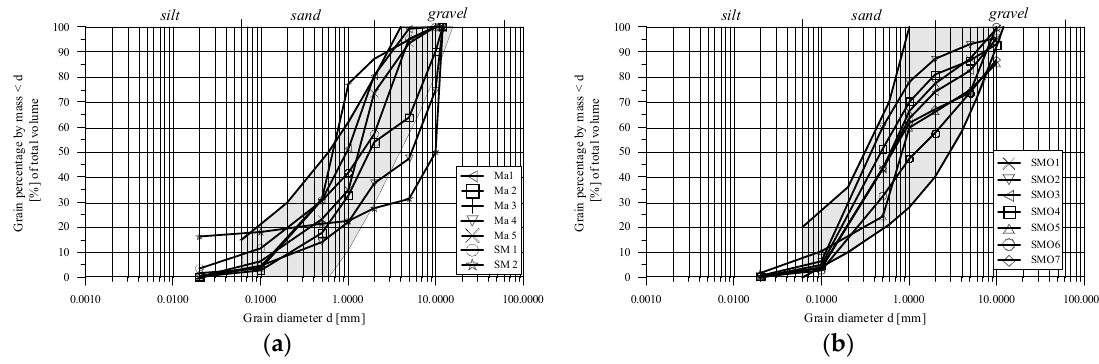
Figure 1. Grain size distribution of substrates analyzed in the study on the background of limit curves from [33] for extensive ( a ) and intensive substrates ( b ). Assessment procedure: PN EN 933-1:2012 [34].